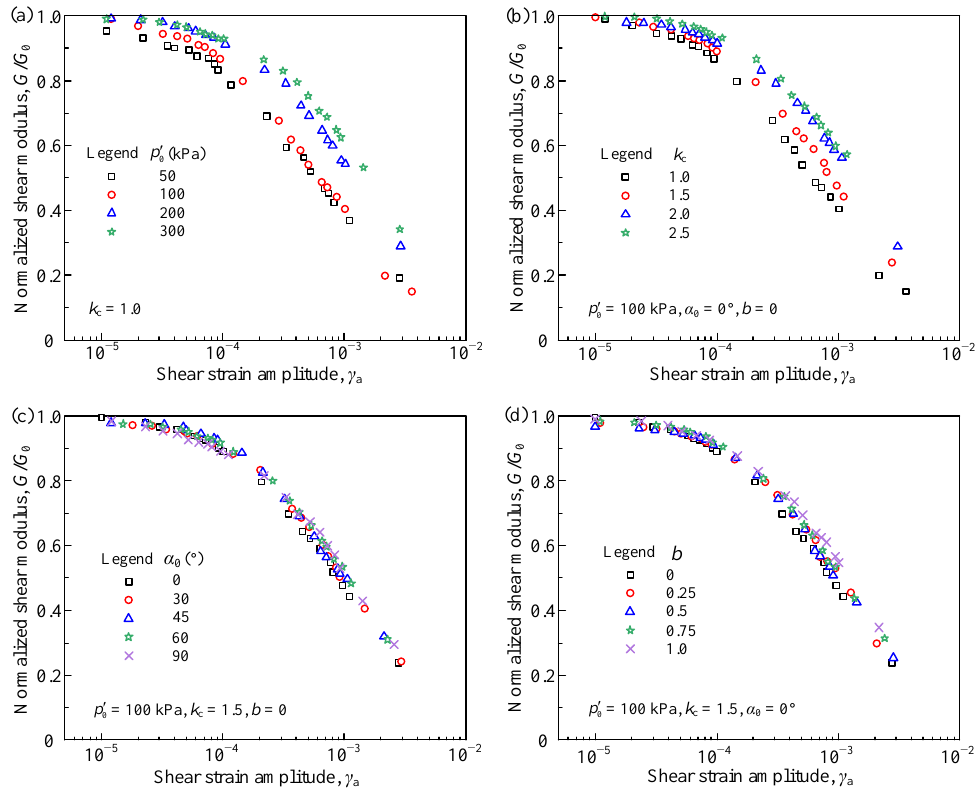
Figure 10. G 0 versus γ a curves of isotropically and anisotropically consolidated saturated coral sand for the undrained cyclic torsional shear tests under various ( a ) effective mean principal stress, ( b ) consolidation ratio, ( c ) consolidation direction angle, and ( d ) coefficient of intermediate principal stress.